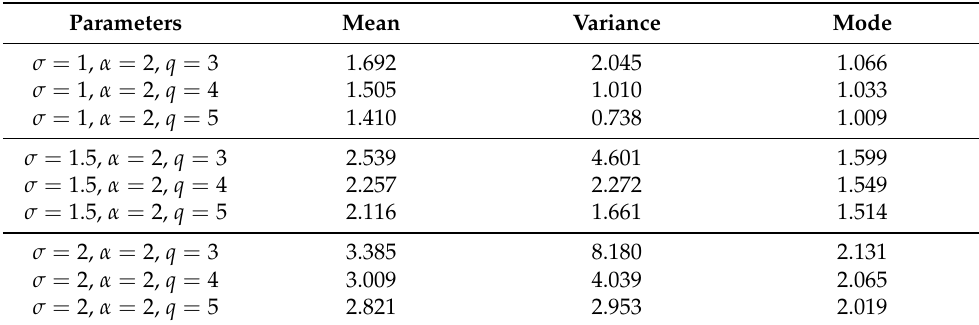
Table 2. Values of mean, variance and mode.